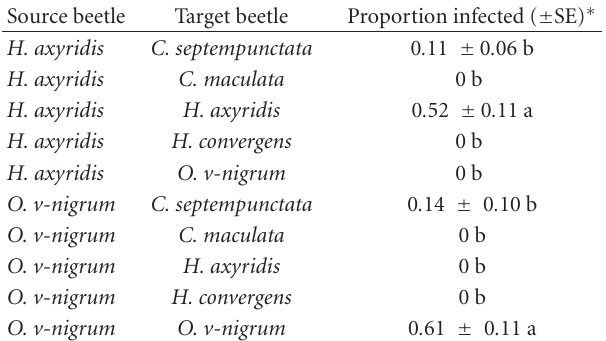
Table 2: Previously noninfected target lady beetles infected with the ectoparasitic fungus H. virescens when a pair of target and source lady beetles were placed in a vial and tumbled on a vial roller for 1h. Source and target beetles were then separated and target beetles observed for mature thalli over the next month.